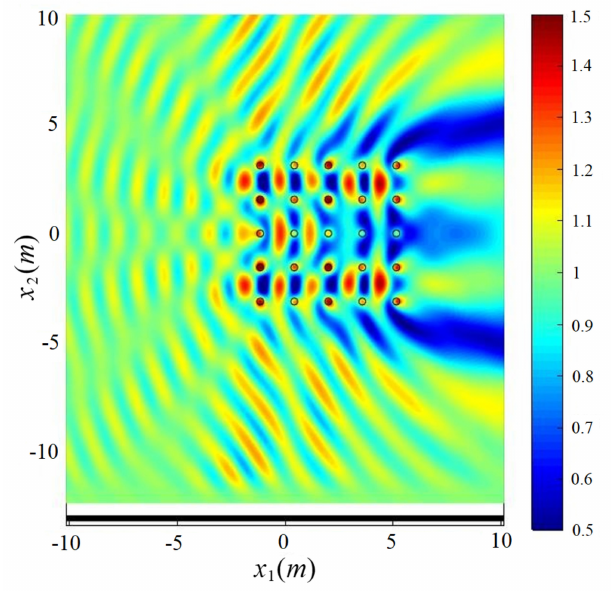
Figure 12. Calculated wave height distribution, normalized with respect to the incident wave height, for a WEC array in constant depth h = 0.7 m modelled by 25 inclusions in a 5 × 5 arrangement obtained by the present MMSE (with β = 0.1, α = 2), for harmonic incident waves of period T = 1.26